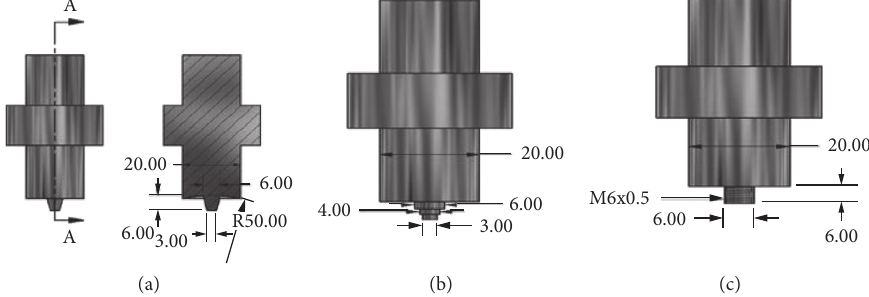
Figure 5: Design of the friction stir welding tool. (a) Involve type (IT). (b) Step type (SS). (c) Thread type (ST).